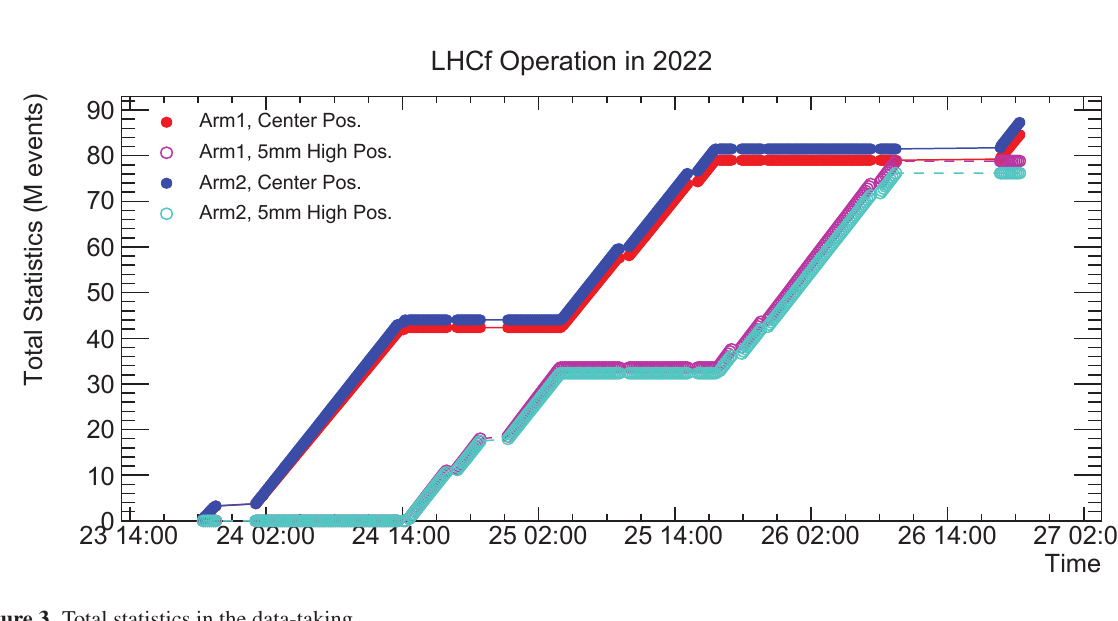
Figure 3. Total statistics in the data-taking.